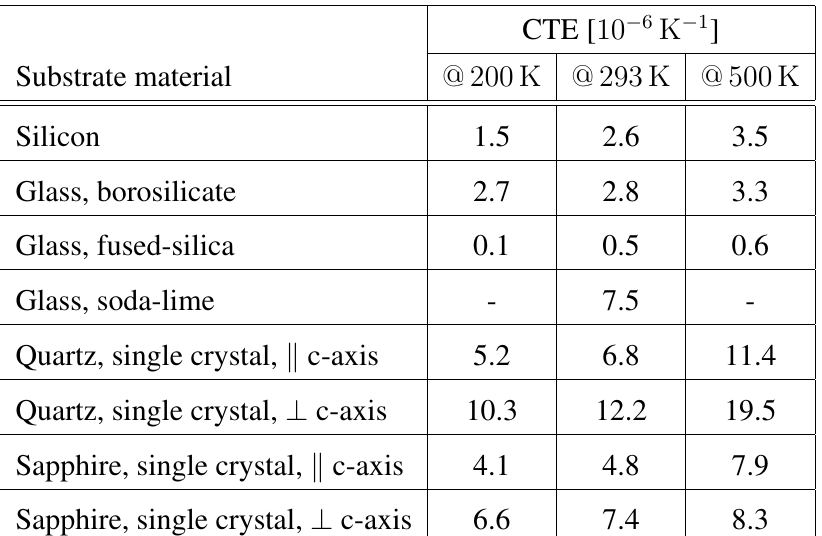
Table 1. Coefficients of thermal expansion (CTEs) of silicon and substrates that are transparent in the visible band